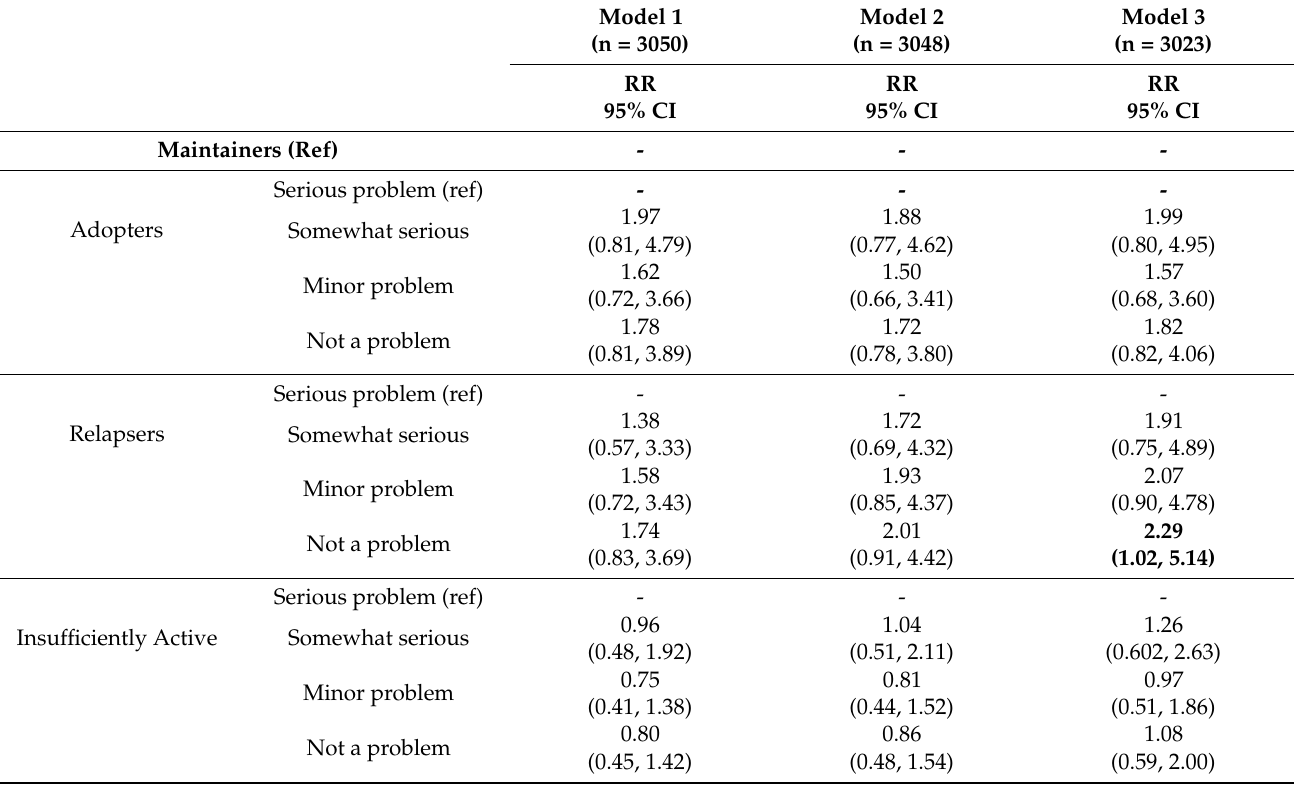
Table 3. Multinomial regression models assessing the association between the perception of lack of parks and playgrounds in the neighborhood and patterns of PA